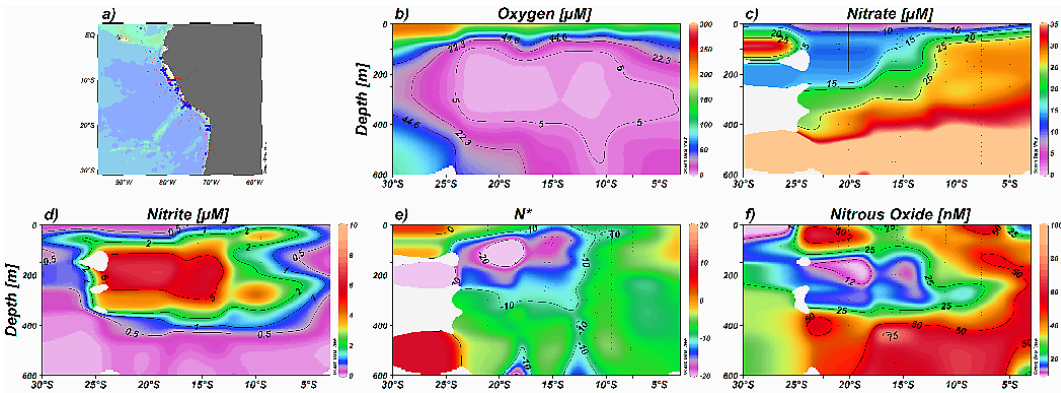
Fig. 1. (a) Study area. Blue points indicate the stations included in meridional vertical distributions of (b) oxygen [µM]; (c) nitrate [µM]; (d) nitrite [µM]; (e) N ∗ according to Deutsch et al. (2001); and (f) nitrous oxide [nM].